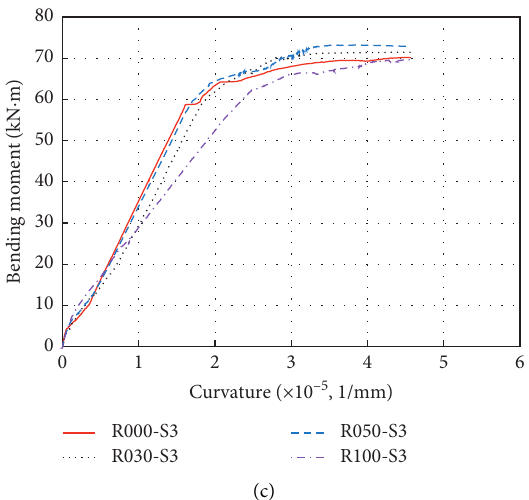
Figure 11: Bending moment versus curvature. (a) Beams with a rebar ratio of 0.50%. (b) Beams with a rebar ratio of 0.79%. (c) Beams with a rebar ratio of 1.14%.